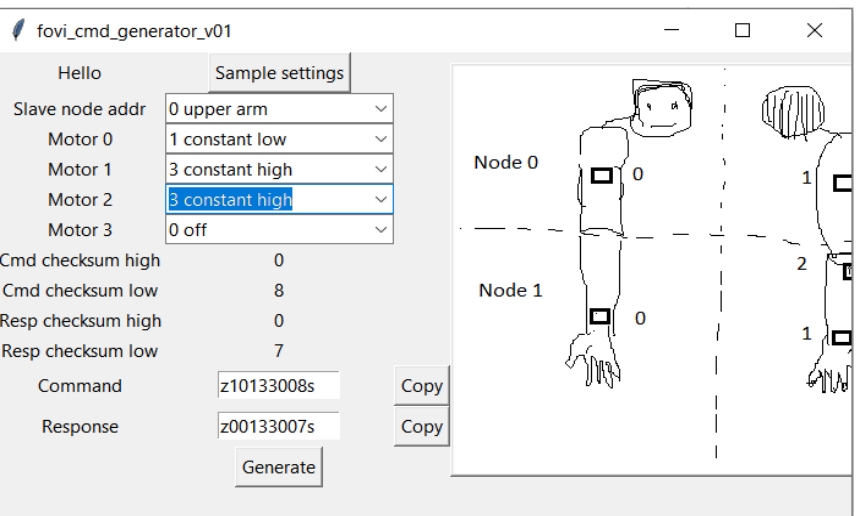
Figure 7. FoVi Command Generator. Graphical user interface for generating encoded command packets. The therapist can select the slave device node and the setting for each of the four vibration motor pods. An illustration of their locations is included for easy identification.